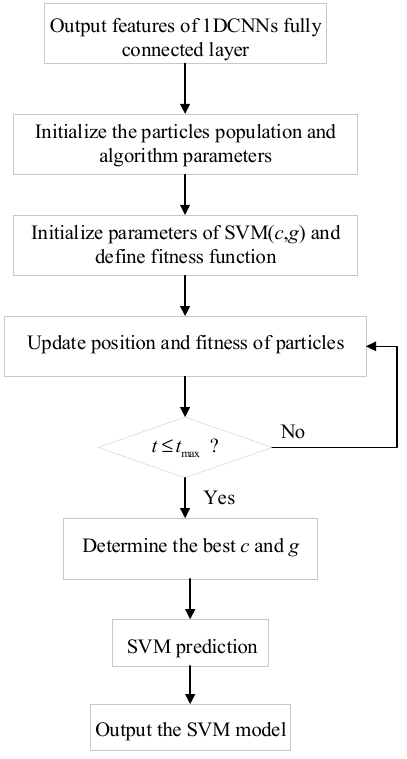
Figure 3. INPSO-SVM flow chart.